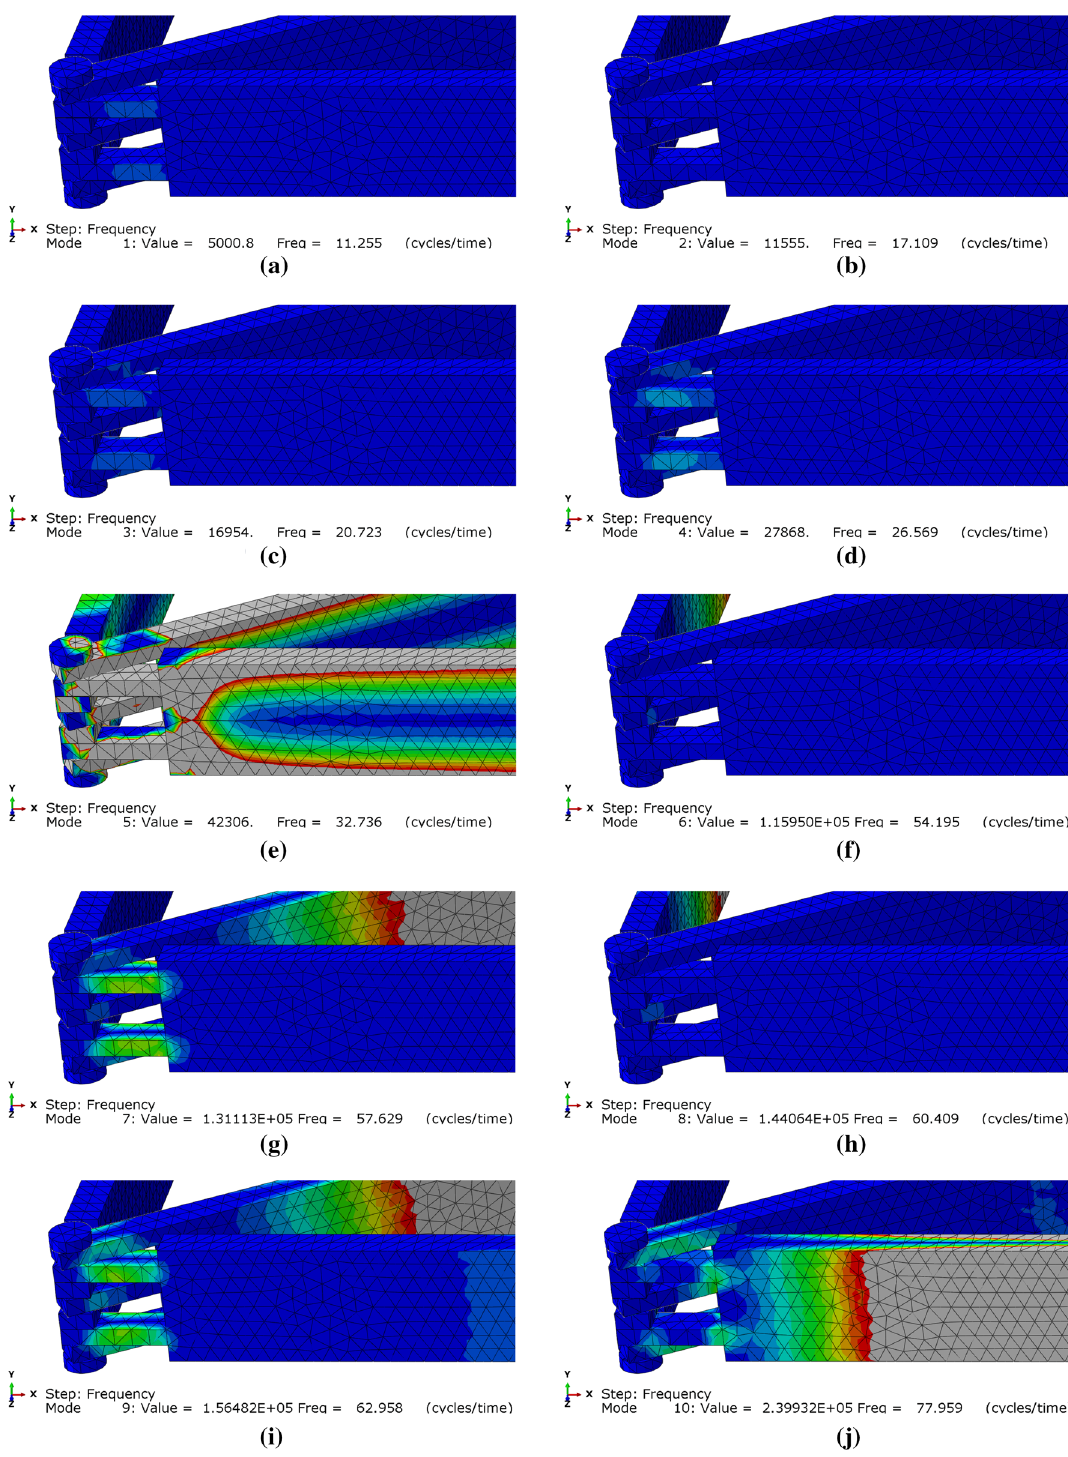
Fig. 16 Strain energy distributions in the joint, the a – j first-10th modes of vibration, FE modal